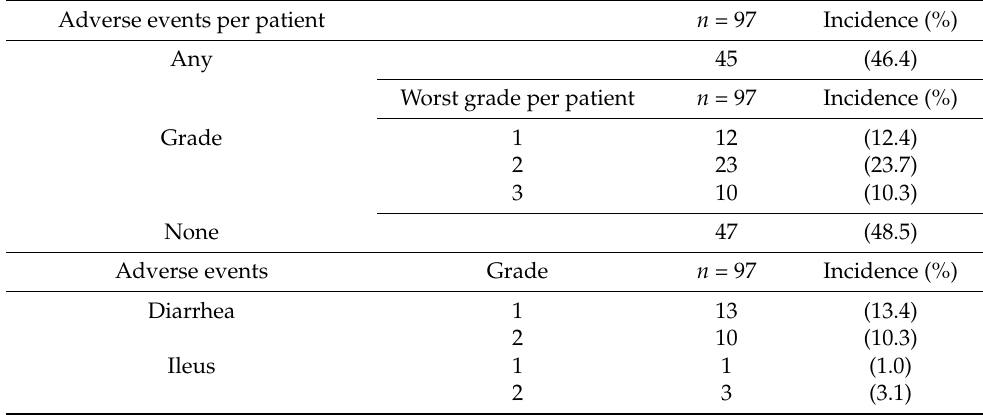
Table 6. Postoperative late adverse